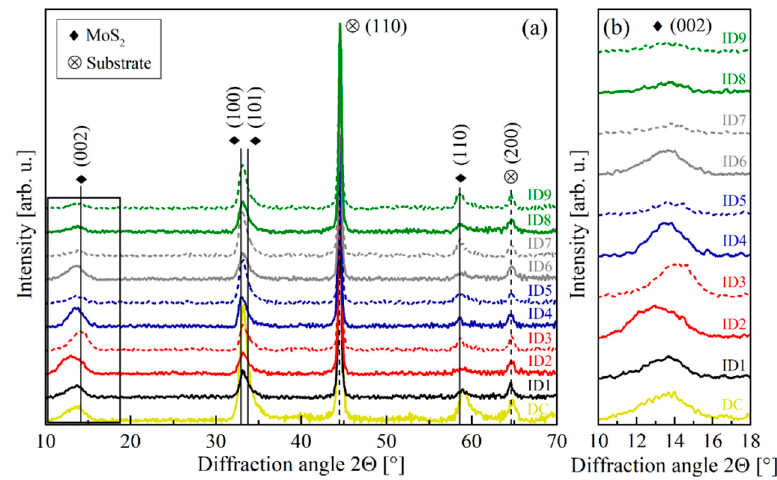
Figure 4. ( a ) XRD spectra of the HiPIMS and DC sputtered MoS x films. ( b ) Detailed view on the shifts of the (002)-MoS 2 Bragg